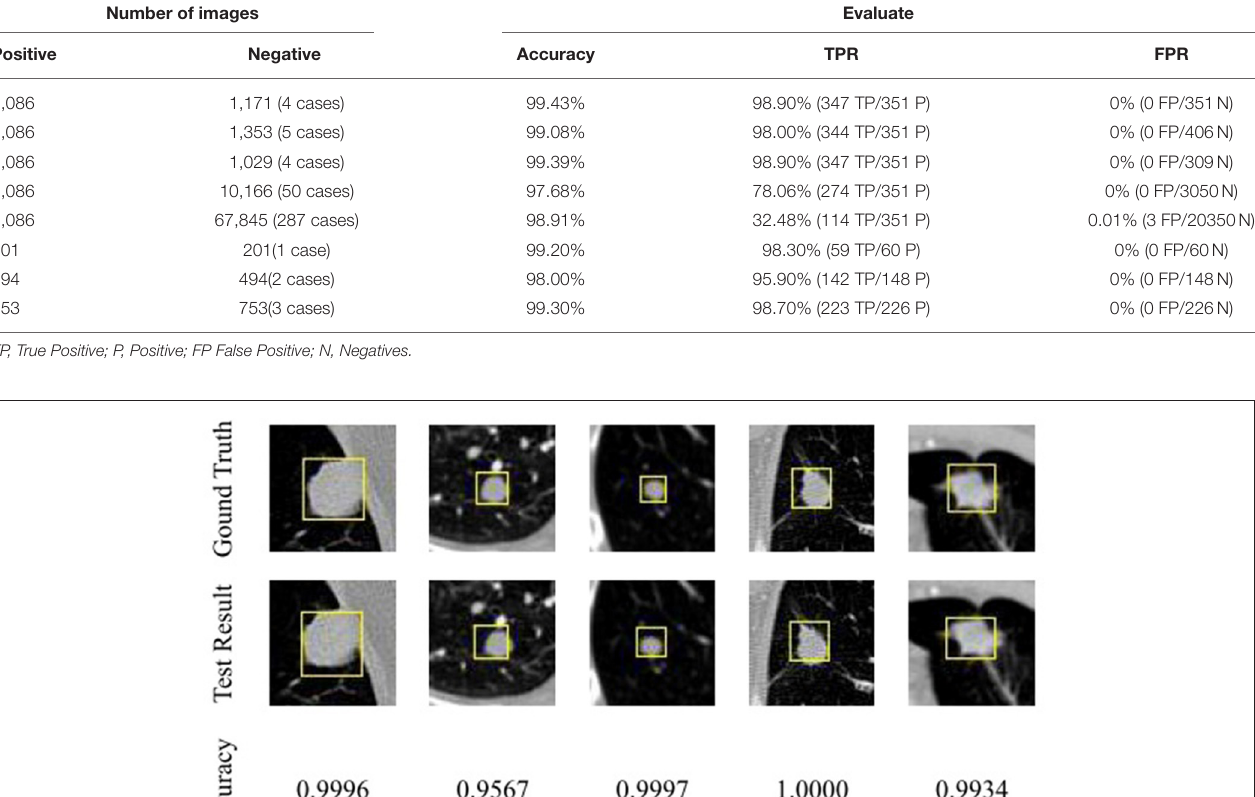
TABLE 1 | Summary of inference different ratio of training data, presenting the accuracy. Number of images